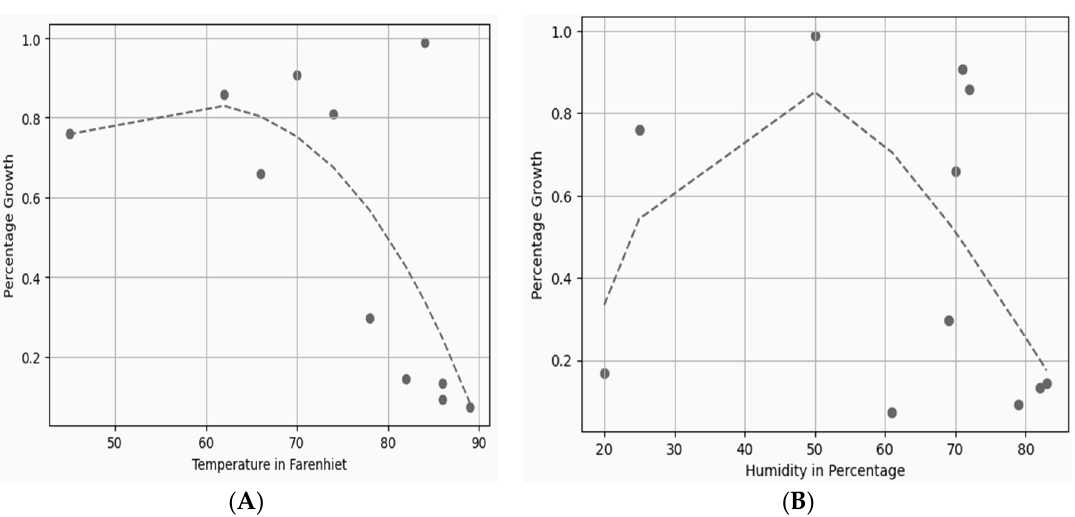
Figure 10. ( A ) Temperature and percentage growth plot; ( B ) humidity and percentage growth plot.